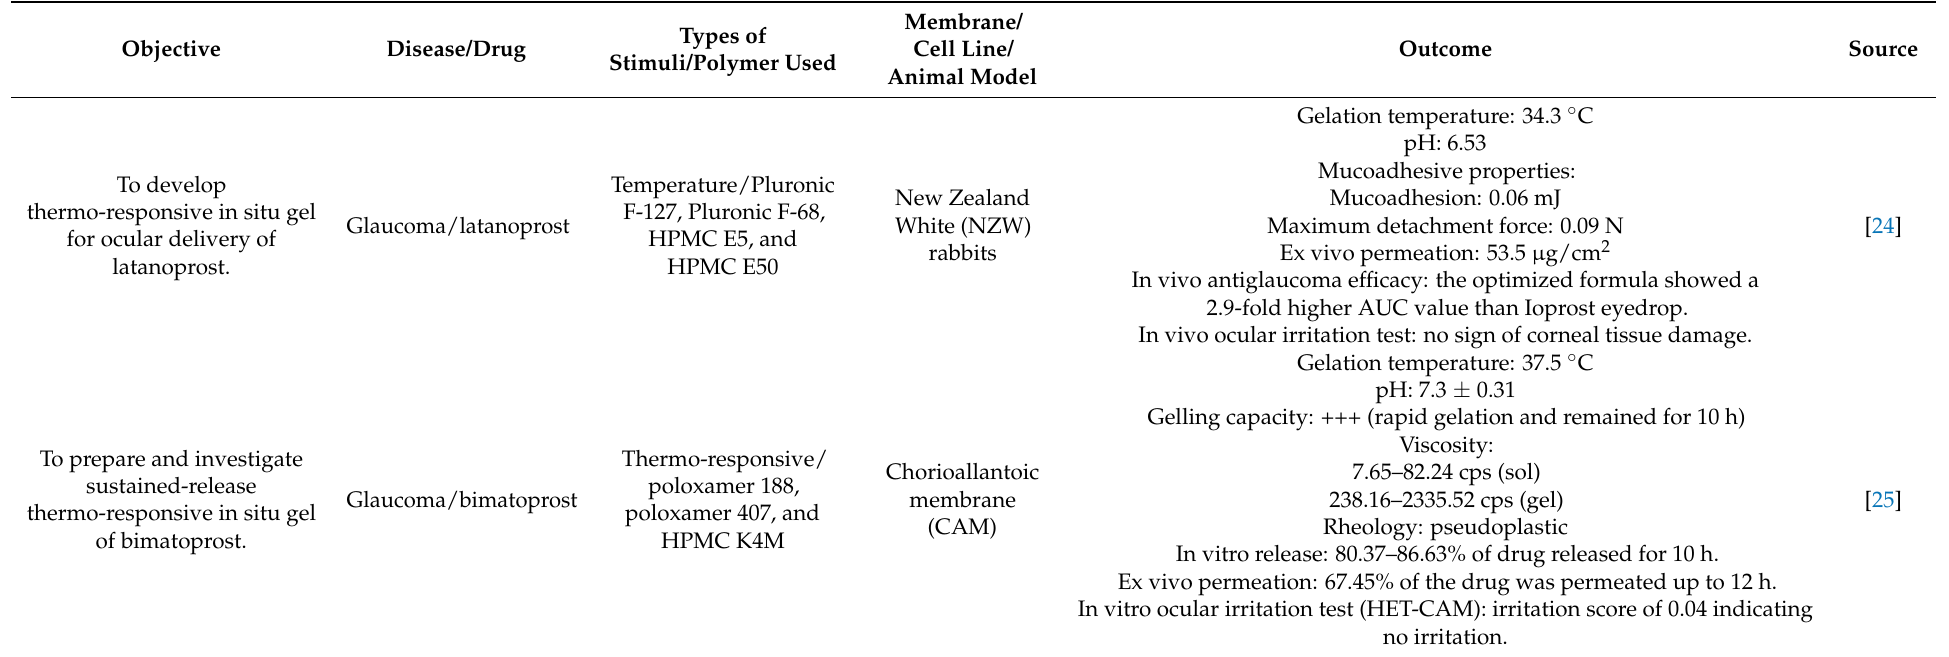
Table 1. Smart ocular delivery using thermo-responsive in situ gel approach against ocular